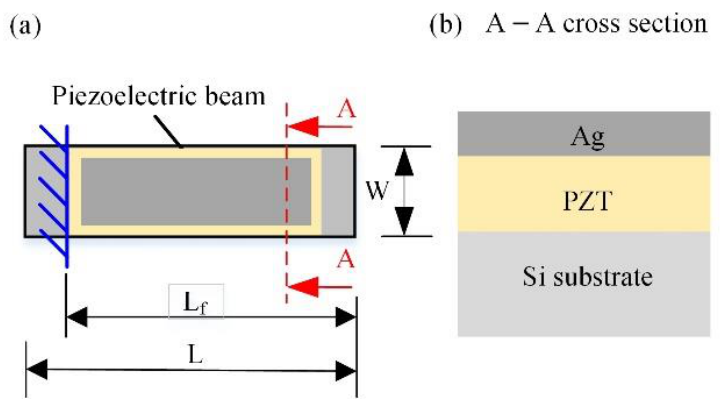
Figure 2. The piezoelectric composite cantilever beam. ( a ) Dimension diagram. ( b ) The material of each layer.